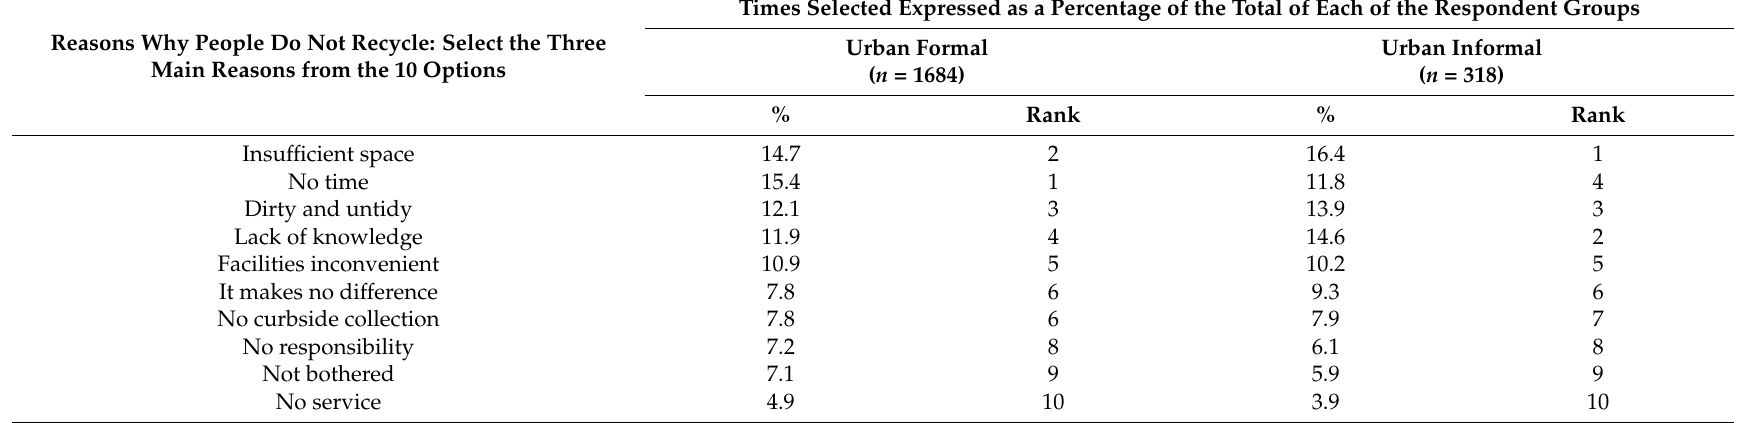
Table A4. Reasons why people do not recycle as enumerated per area type: urban formal or urban informal ( n = 2002